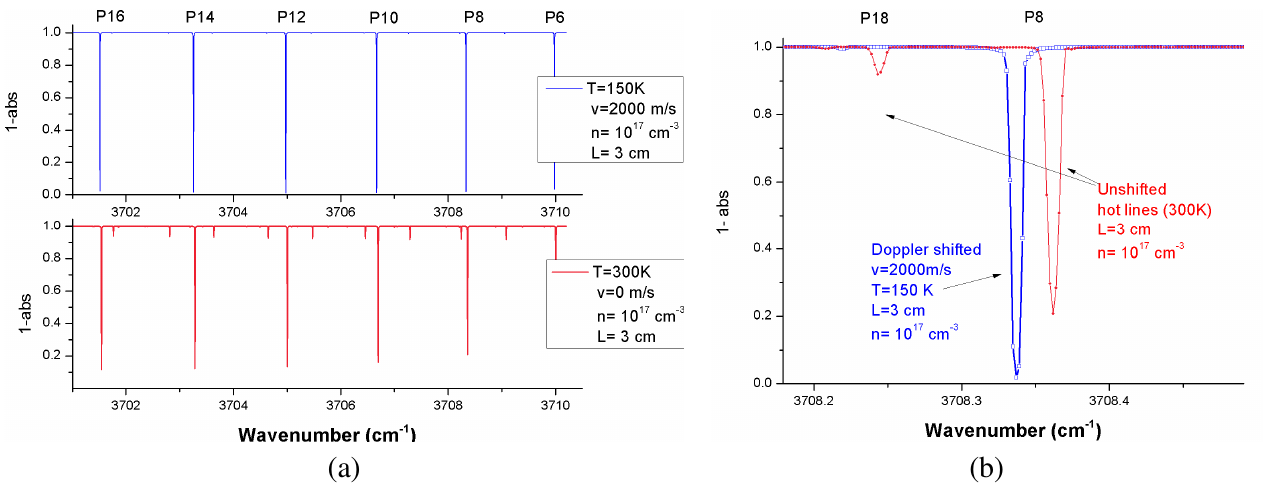
absorption spectrums for VKI run 2